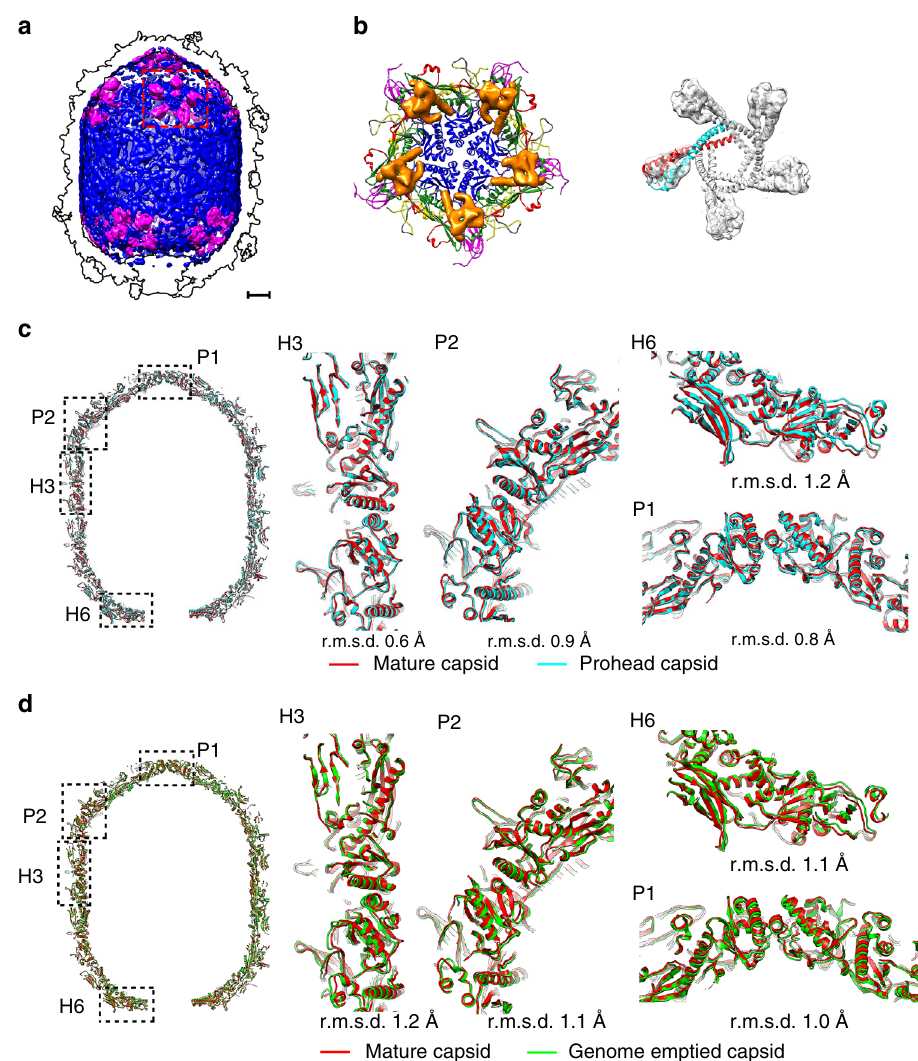
Fig. 4 Structure of the scaffolding protein and structural comparisons of the capsids. a Surface shadowed diagrams showing the internal scaffolding proteins of the prohead (magenta). The weak density shell in the prohead capsid is colored blue. The outline of the capsid is indicated with black lines. The scale bar represents 5 nm. b Ribbon and shadowed-surface diagrams showing the attachment of fi ve scaffolding dimers (surface shadowed and colored orange) to a pentameric capsomer (in ribbon); right: fi tting of the scaffolding dimers into the EM density map. c Structural comparisons of the prohead (blue) and the mature head (red) capsids. Left: overall comparison; middle and right: zoom-ins showing the subtle differences at different parts of the head. The scale bar represents 5 nm. d Structural comparisons of the mature head (red) and the genome emptied head (green) capsids. Left: overall comparison; middle and right: zoom-ins showing the subtle differences in different parts of the head. The scale bar represents 5